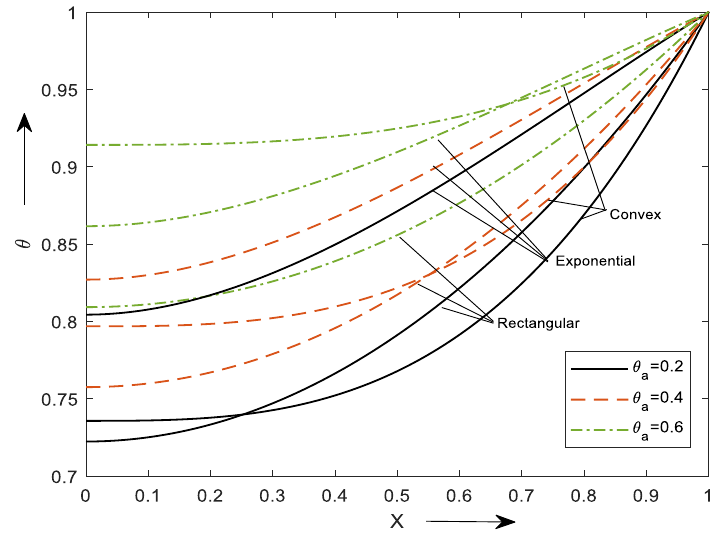
Figure 7. Behavior θ a on θ . The effect of parameters on temperature for rectangular, exponential and convex